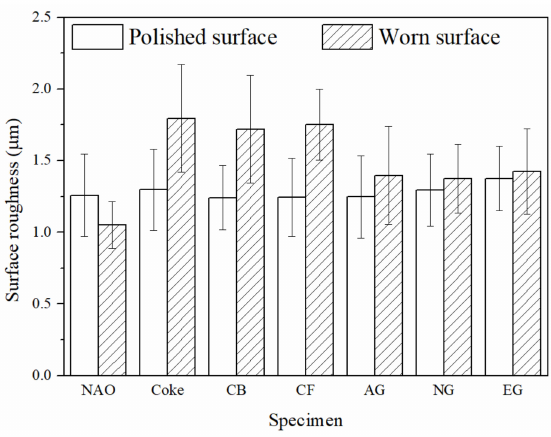
Figure 11. The surface roughness of